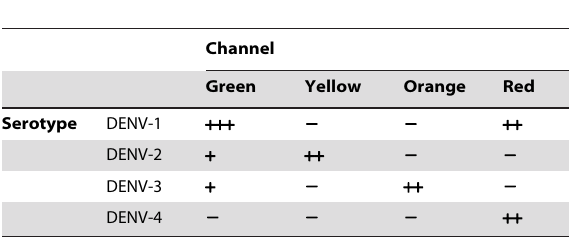
Table 3. Probe signals for each DENV